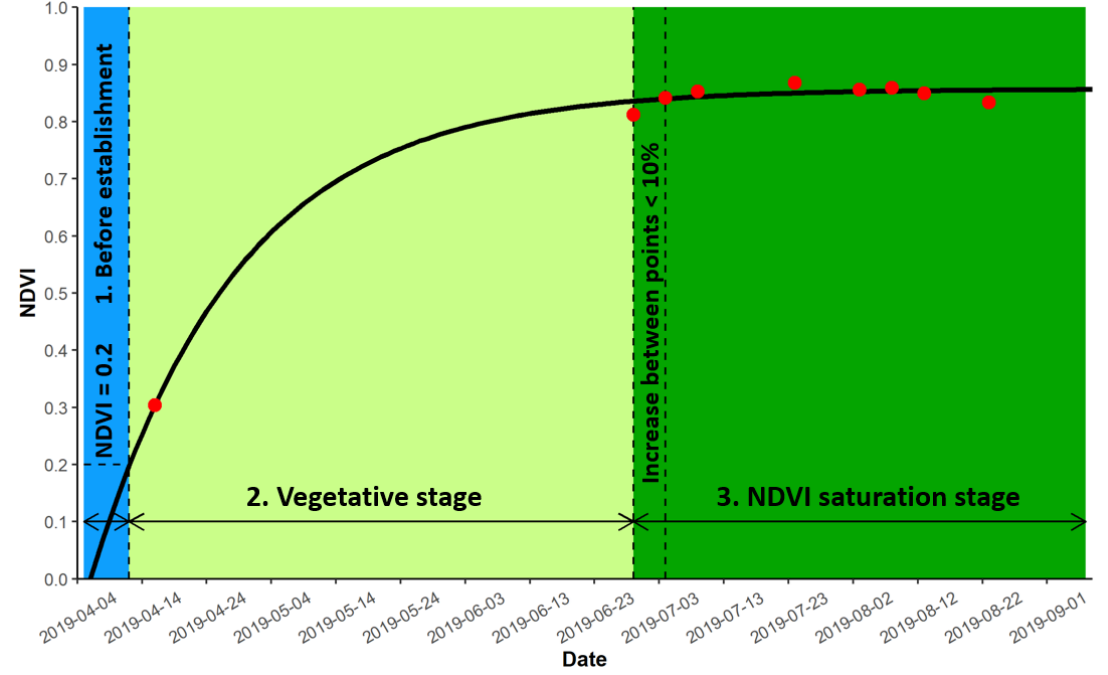
Figure 3. Visual representation of classifying three different stages based on the growing season, model, and NDVI dataset derived from Sentinel-2 images (red points).